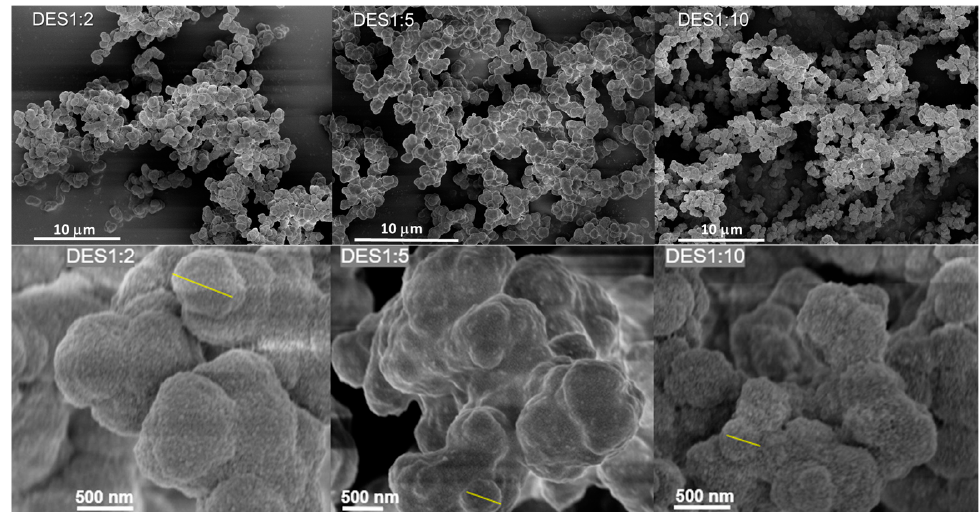
Figure 1. SEM images of the LRF cryogels with di ff erent DES ratios (10 µm and 500 nm).